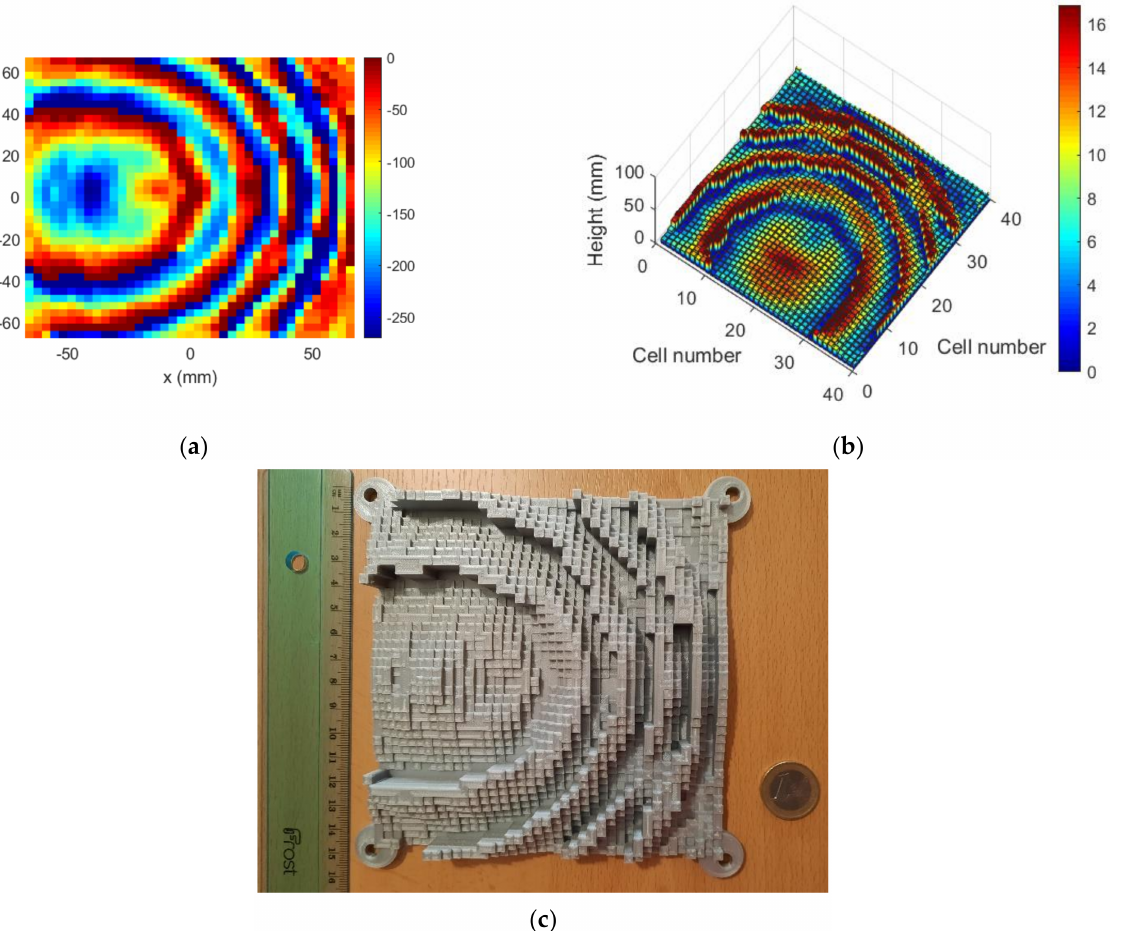
Figure 10. Case 1, dielectric TA: ( a ) required phase (0 ◦ –270 ◦ ); ( b ) TA design; ( c ) fabricated